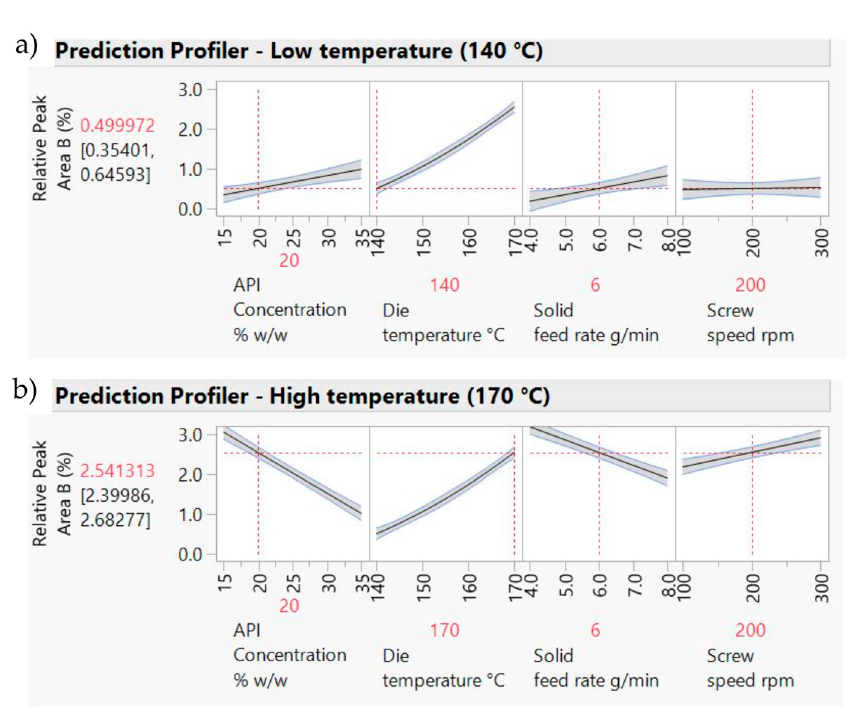
Figure 14. DoE model showing the impact of process parameters on the Relative area of Peak B. ( a ) Prediction profiler for 140 °C; ( b ) Prediction profiler for 170 °C